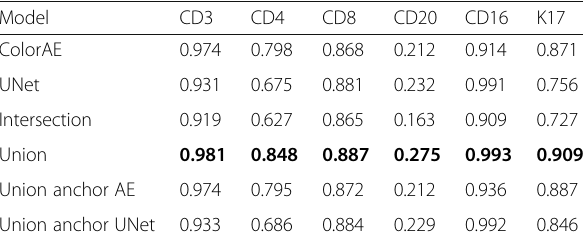
Table 3 Sensitivity (Recall) evaluating predictions from UNet, ColorAE, and ensemble methods against dilated eed labels Model